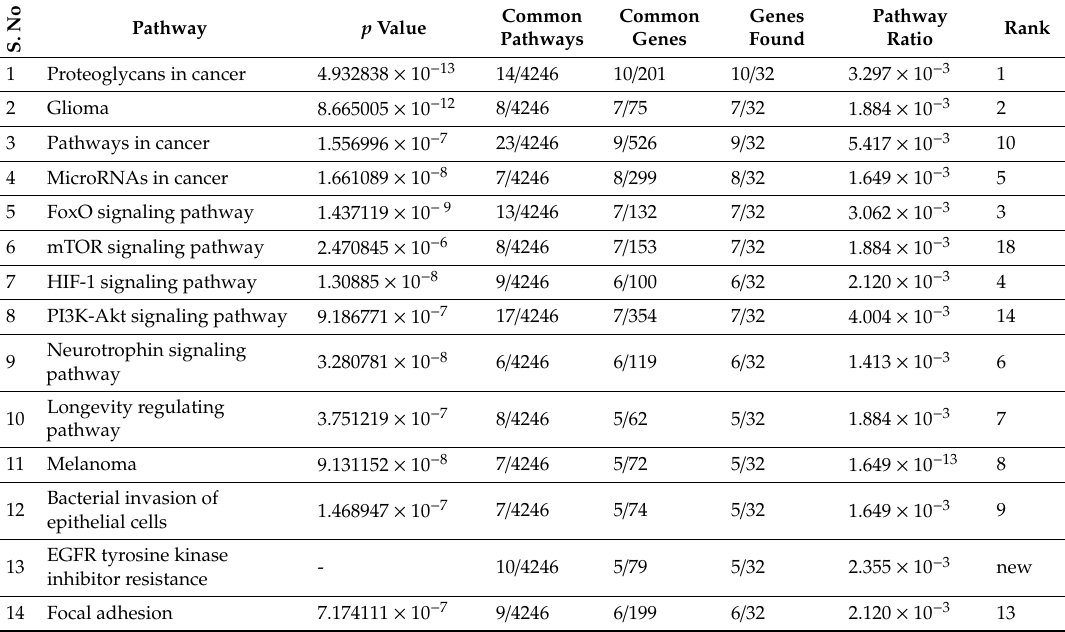
Table 3. PathwayConnector—complementary pathway networks by HOMA-IR